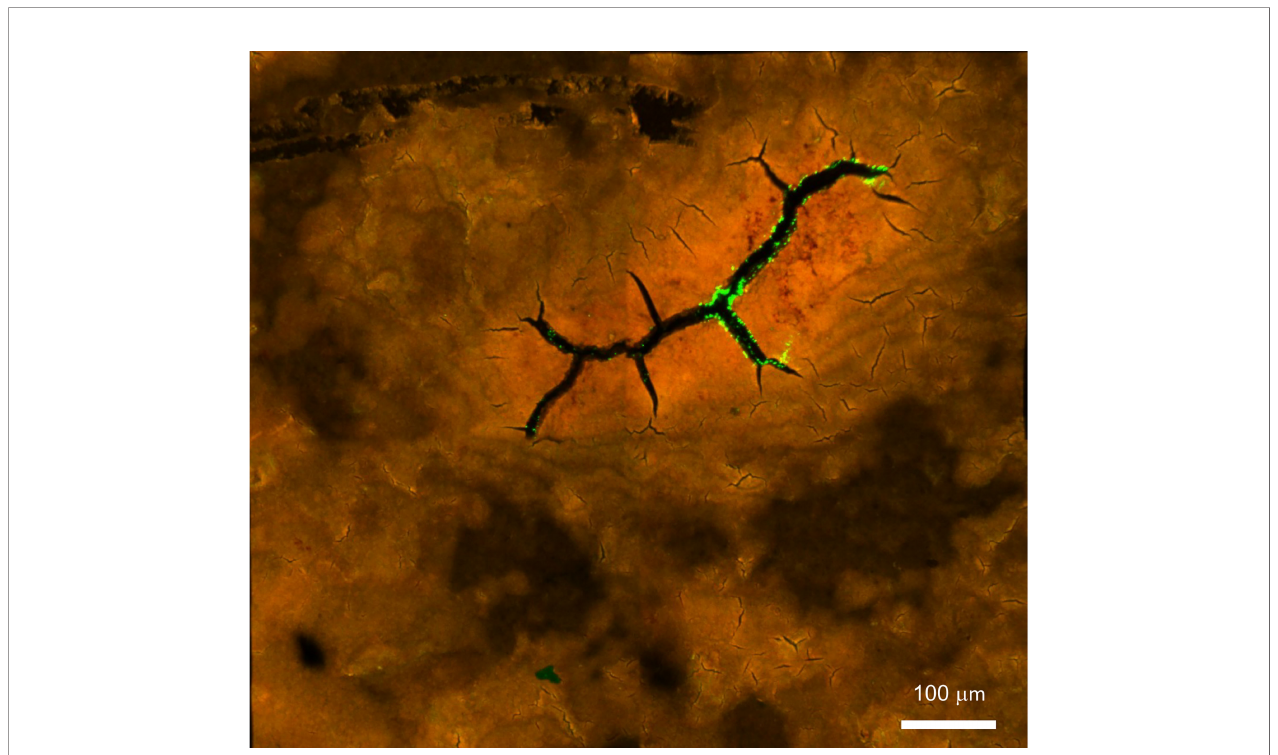
FIGURE 9 | Confocal fl uorescent image of Salmonella Typhimurium on the outer surface of white ungraded chicken eggshell cuticle. S. Typhimurium localized near cracks and fi ssures of cuticle on the outer surface of ungraded eggshell. Red fl uorescence= cuticle protein; Green fl uorescence= GFP expressing S. Typhimurium cells. (Original fi gure by